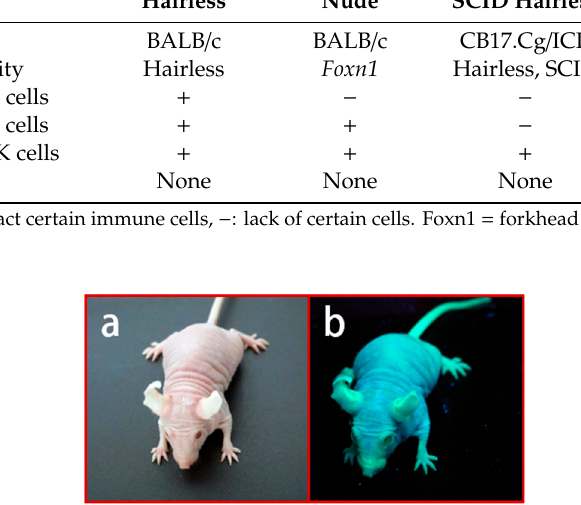
Figure 3. Green fluorescence protein (GFP) ‐ expressing Nude R/J mice: ( a ) GFP Nude R/J phenotype; ( b ) strong GFP expression under β‐ actin promoter yields a very bright green signal under UV light [46]. Table 3. Comparison of hairless mice.